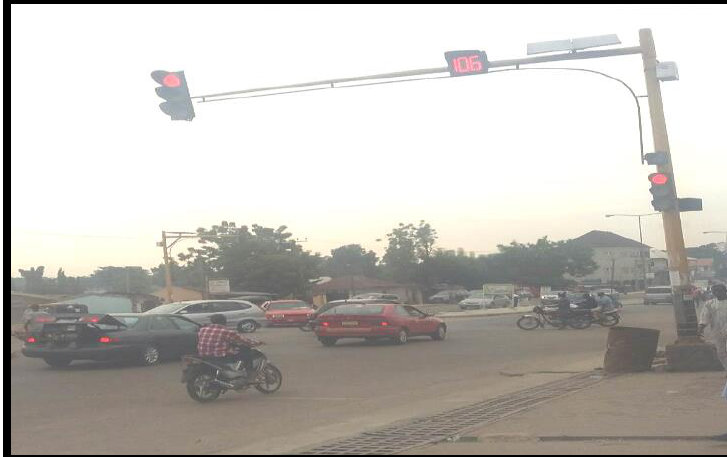
Figure 4. Red Light Running, Private Vehicles